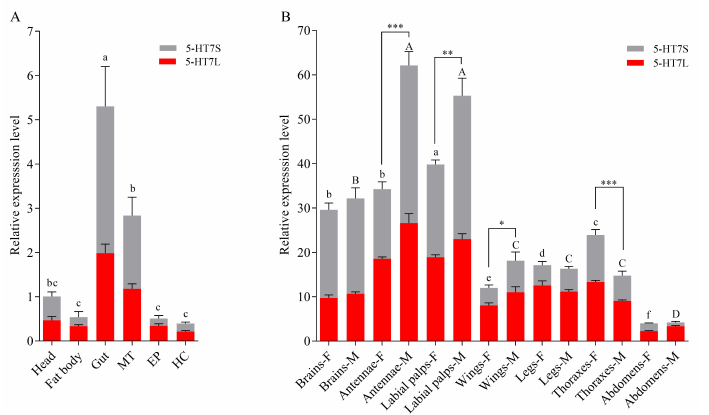
Figure 5. Expression profiles of transcripts encoding Msep5-HT7 in Mythimna separata . ( A , B ) Relative expression levels of Msep5-HT7S and Msep5-HT7L receptor genes in different tissues of larvae and adults, as evaluated by qPCR. Significant differences in expression in larval tissues using one-way ANOVA and Tukey’s multiple comparison test ( p < 0.05) are marked above each bar, with lowercase letters in ( A ). Significant differences in expression in male and female tissues using Tukey’s multiple comparison test ( p < 0.05) are marked on bars with uppercase and lowercase letters. Differences in relative mRNA expression of Msep5-HT7 between sexes were compared by Student’s t -test for ( B ); * p < 0.05, ** p < 0.01, *** p < 0.001. MT, malpighian tubules; EP, epidermis; HC, hemocyte. Tissue names with letters F and M indicate female and male,